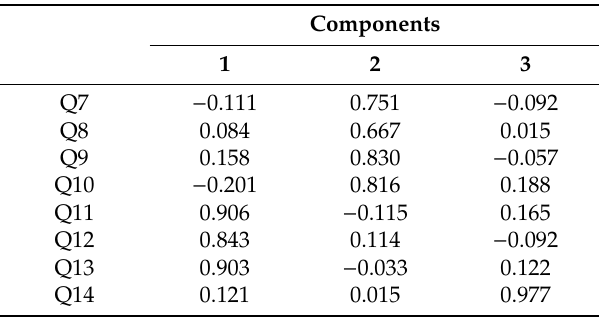
Table 6. Rotated component matrix.